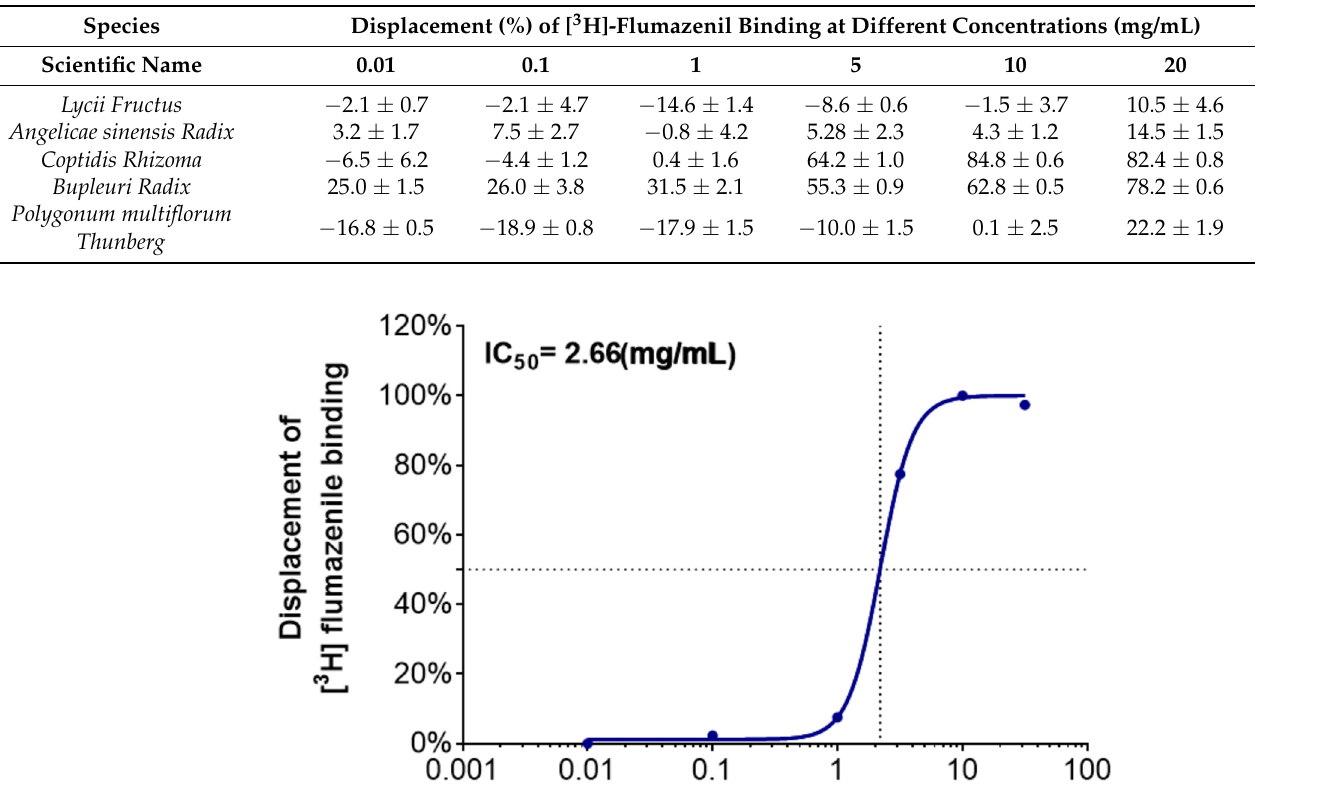
Table 1. Displacement of the [ 3 H]-flumazenil binding of water extracts of medicinal plants to the GABA A –BZD receptor in the rat cerebral cortex.